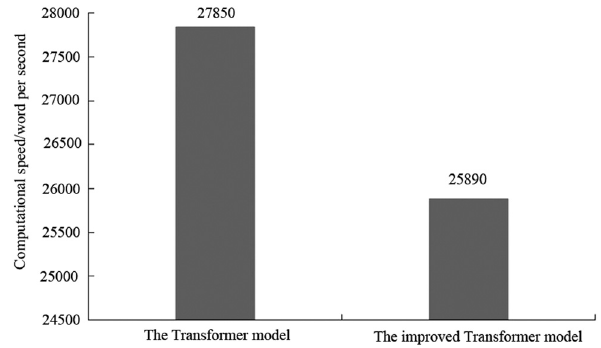
Figure 4: Comparison of computing speed between di ff erent models.